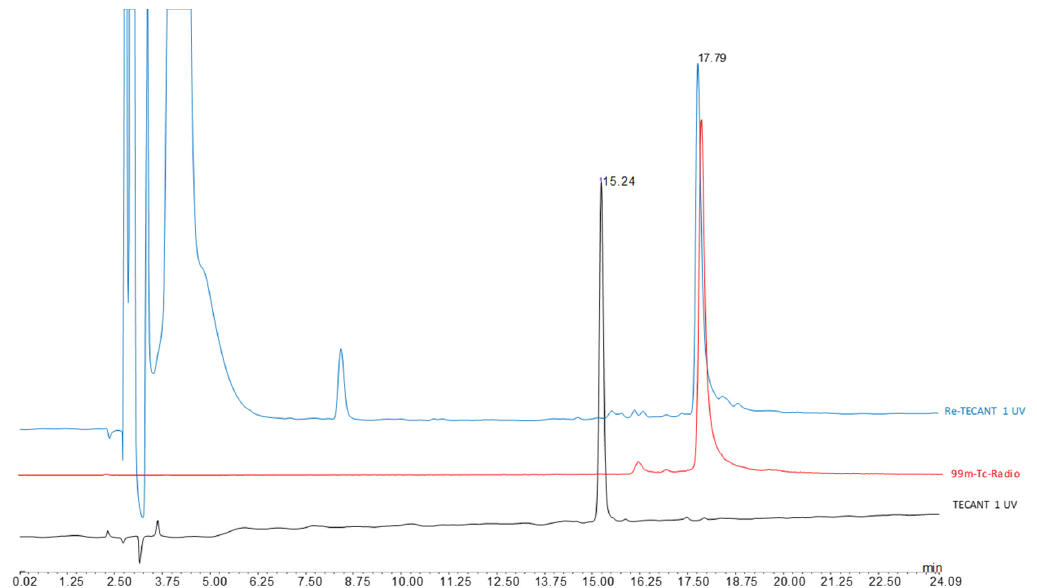
Figure A2. HPLC chromatogram of [ nat Re]Re-, [ 99m Tc]Tc- and unlabelled TECANT-1 (confirmative mass spectrometry data available on request).